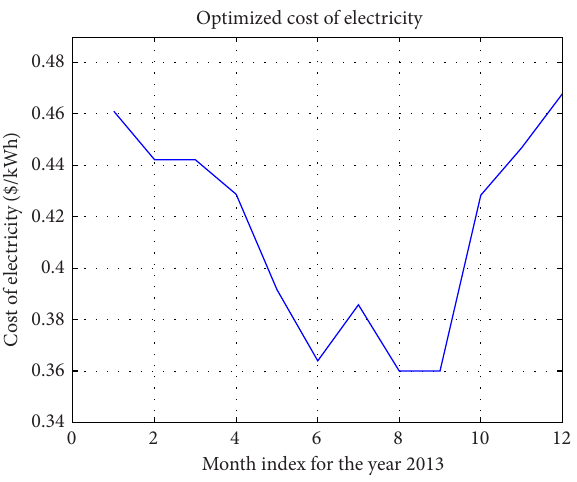
Figure 5: Distribution of energy supply based on linear program- ming approach (case of Accra).